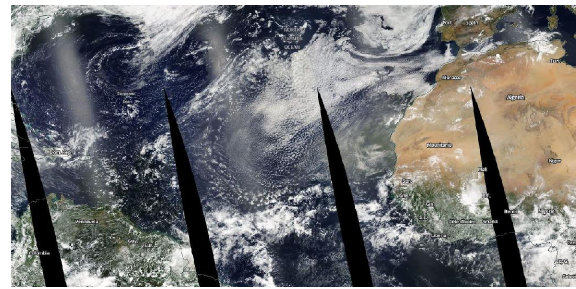
Figure A1. Dust storm on 2 July 2013.